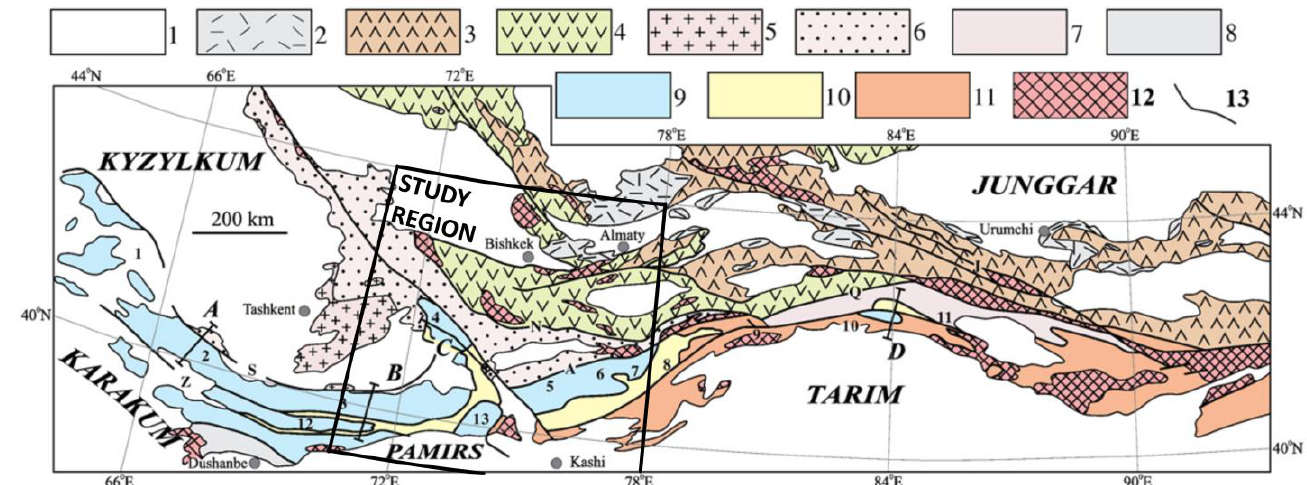
Figure 2. Simplified geological map of the Paleozoic Tien Shan from [60]. 1—Mesozoic–Cenozoic cover; 2–3—North-Eastern Tien Shan: 2—active margin volcanic belt and collision-related molasse (Upper Carboniferous to Lower Permian), 3—accreted arc terranes (volcanic rocks and associated formations) (Devonian–Upper Carboniferous, locally Silurian); 4—Northern Tien Shan: island arc Lower Paleozoic complexes, partly with the Upper Paleozoic cover; 5,6—Middle Tien Shan: 5—Chatkal–Kurama accretionary terrane (before the Devonian) and volcanic–plutonic belt of the Kazakhstan active margin, 6—Syr Darya and Talas passive margin sediments (Neoproterozoic to Carboniferous); 7–10—Southern Tien Shan: 7—Erben–Kymyshtala accreted arc and possible forearc complex (Devonian), 8—active margin and rift formations of the Karakum–Tajik continent (Carboniferous), 9—Bukantau–Kokshaal collisional fold-thrust belt: accreted arc and ophiolites, passive margin sediments of the Kyzylkum–Alai and other microcontinents (mainly Silurian to Carboniferous), 10—turbidites and molasses of the syn-collisional foreland basin in the Tarim and Turkestan–Alai; 11—deformed sedimentary cover of the Tarim; 12—Precambrian basement; 13—main faults and thrusts.